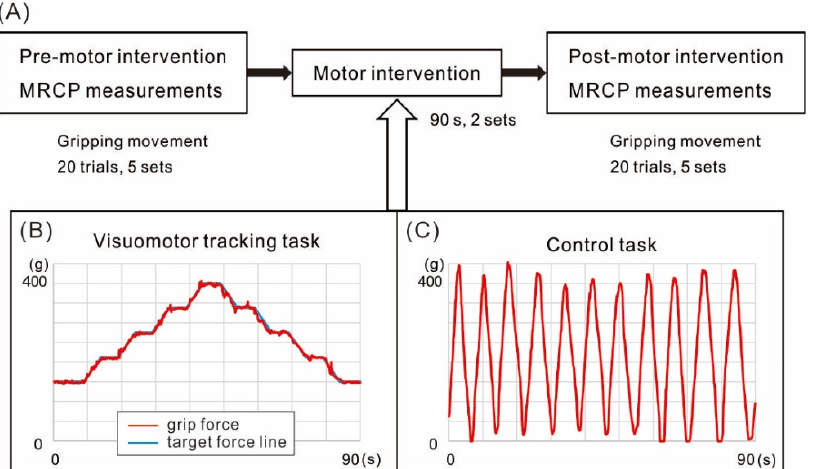
Figure 1. Schematics of the experimental design and motor interventions. ( A ) The experimental design. Movement-related cortical potentials (MRCPs) were measured from the scalp over motor cortex before (Pre) and after (Post) the two motor interventions. Participants performed hand grip movements every 5–7 s to a peak target force of 400 g. One measurement session was comprised of five sets of 20 trials, with one-minute breaks between sets. Patients preformed these movements with the paretic hand and healthy controls with the left hand. ( B ) The visuomotor tracking task (VM) required participants to replicate the hand grip force pattern shown on a computer screen with simultaneous visuomotor feedback. ( C ) The control task ( C ) required participants to perform repetitive hand grips to 400 g at their own pace with visual observation of the hand but no visuomotor feedback.